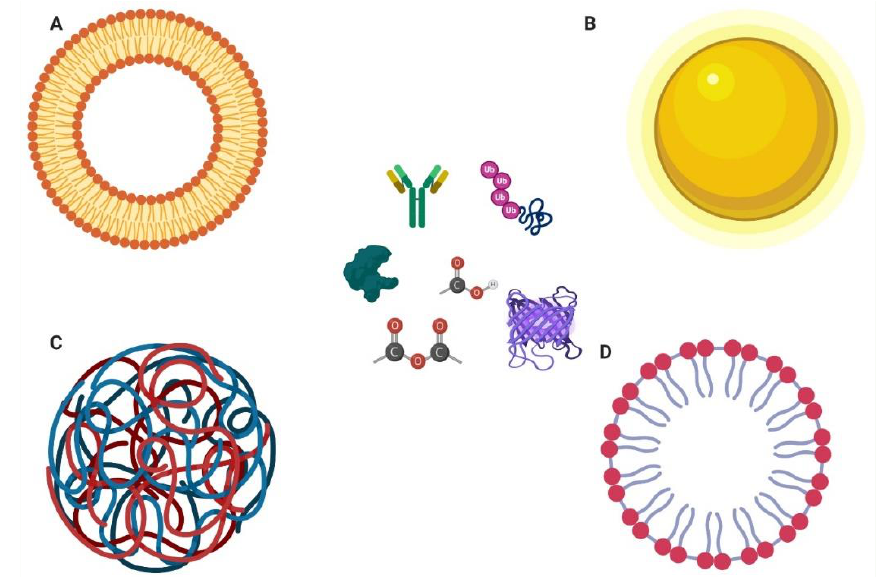
Figure 1. Representation of some controlled drug delivery vehicles, including liposome ( A ), gold Nanoparticles ( B ), polymeric particle ( C ) and micelle ( D ). Using the different systems, it is possible to encapsulate classical antitumor agents, small-molecule inhibitors, monoclonal antibodies, gene target therapies and RNA interference. Created by Biorender (https://app.biorender.com/).